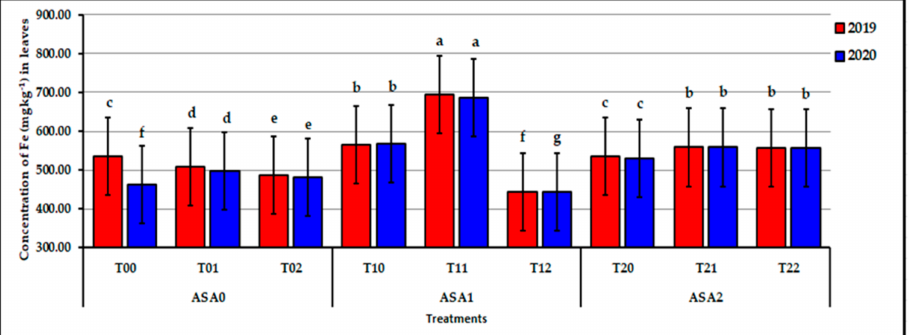
Figure 4. Influence of interaction between zinc oxide nanoparticles and ascorbic acid on leaf Fe content of stressed sweet potato plants in 2019 and 2020 seasons. Bars with a different letter indicate significant difference between treatments at p ≤